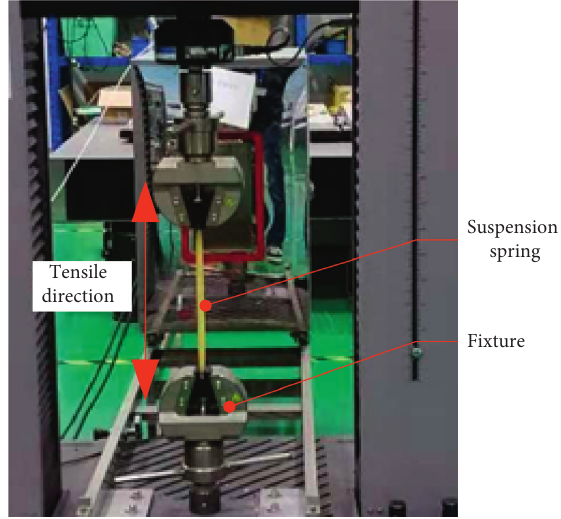
Figure 13: Picture of strip stiffness test experiment.